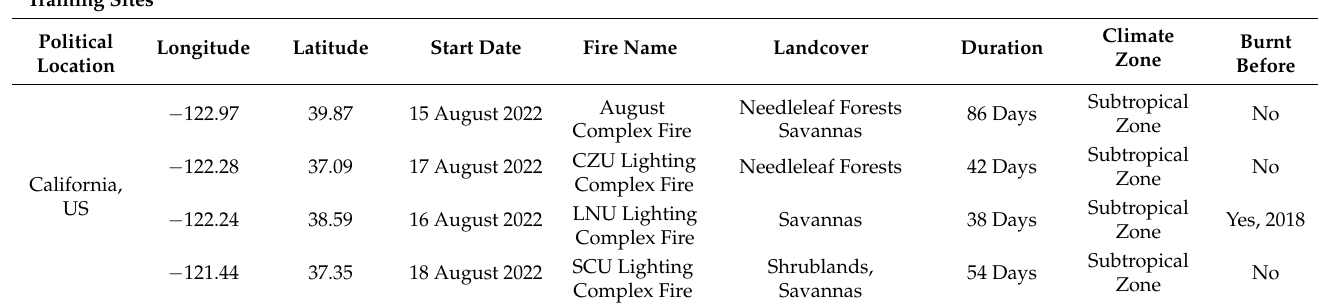
Table 1. Information of Training sites. Duration is the number of days used in the Training dataset. The name of the wildfire are either named after fire names from The Department of Forestry and Fire Protection of California.